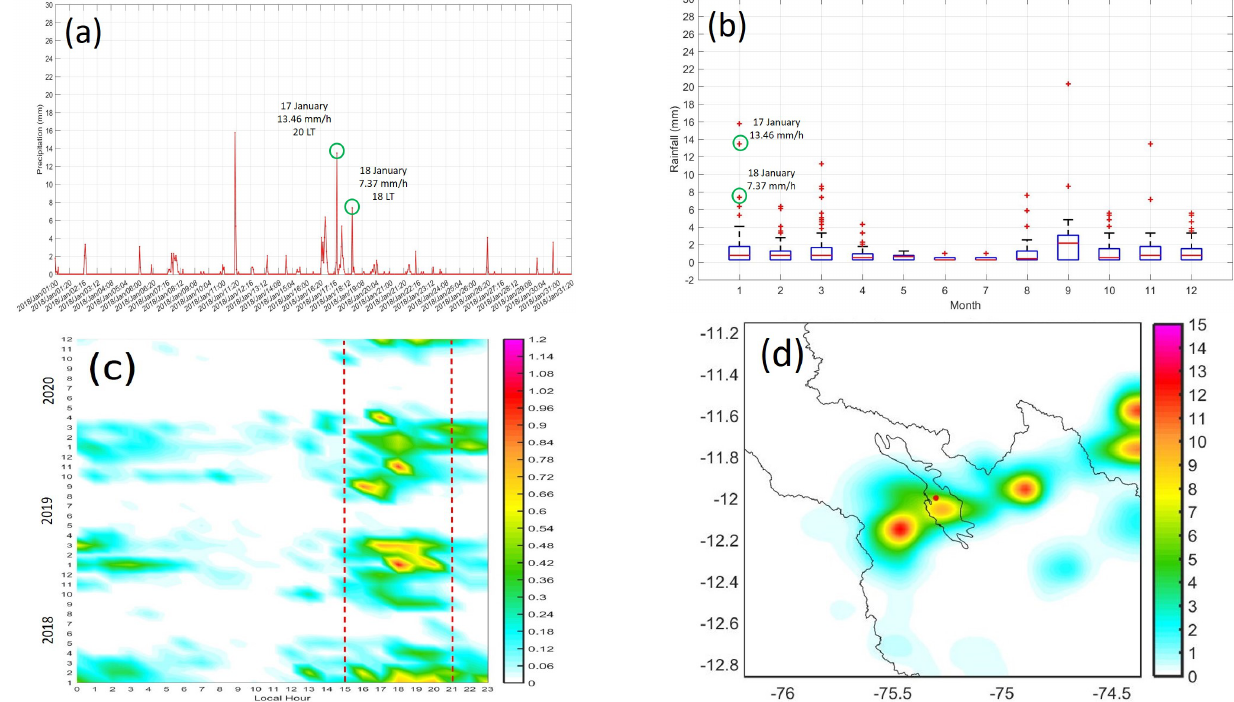
Figure 3. ( a ) Time series of precipitation rate (mm h − 1 ) obtained from an in situ pluviometer (red line) above the HYO during January 2018. ( b ) Monthly variation of hourly accumulated precipitation quantiles (boxplot) above the HYO. Green circles highlight the intensity and time of both the rainfall events on 17 and 18 January, 2018. The rainfall values are outliers that highly exceed the mean monthly precipitation of January, close to 1 mm h − 1 . ( c ) Monthly and diurnal cycles of mean accumulated hourly precipitation above the HYO during the years 2017, 2018, and 2019. The dotted red lines indicate the time period when the greatest amount of rainfall occurs (15 LT to 21 LT). ( d ) Spatial distribution of precipitation rate (mm h − 1 ) for the MV obtained from the GPM data for 17 January, 2018, at 21 LT. Longitudes, latitudes and contours of the MV and MB are indicated. The red circle indicates the location of the